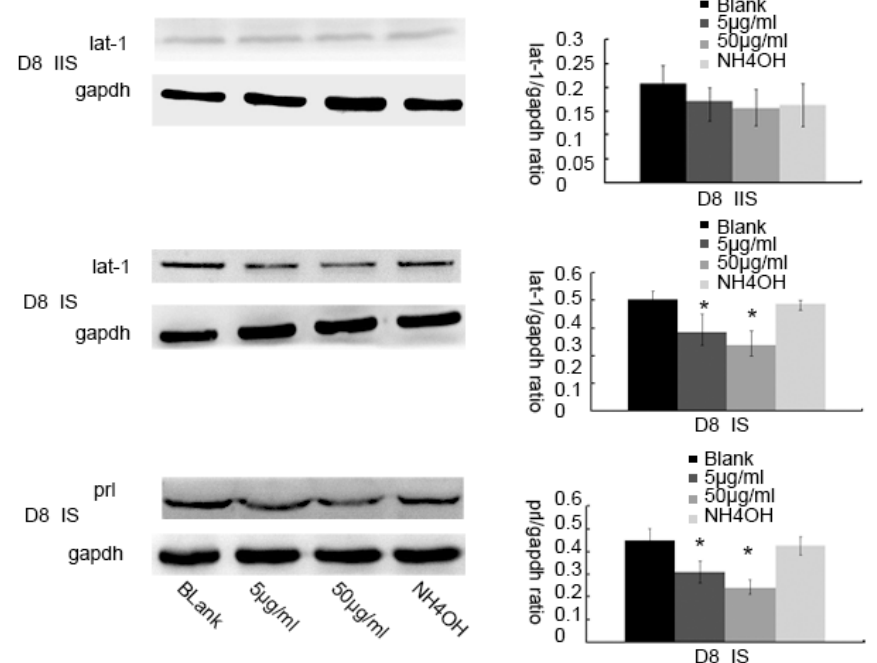
Figure 7. Quantitative expression of BCH effects on prl and lat1 expression on D8 of pregnancy. Samples from D8 of mouse with different treatments were distinguished between implantation sites and inter ‐ implantation sites and then the tissues were analyzed for lat1 and decidualization marker prl protein expression. The expression of lat1 was decreased by BCH treatments in the implantation sites. The protein levels of prlshowedsimilar trends to the lat1 protein levels in implantation sites. These effects in implantation sites were not displayed in inter ‐ implantation sites. IS: implantation sites, IIS: inter ‐ implantation sites. * p < 0.05, as compared with blank control. There were 15 mice sacrificed per group.